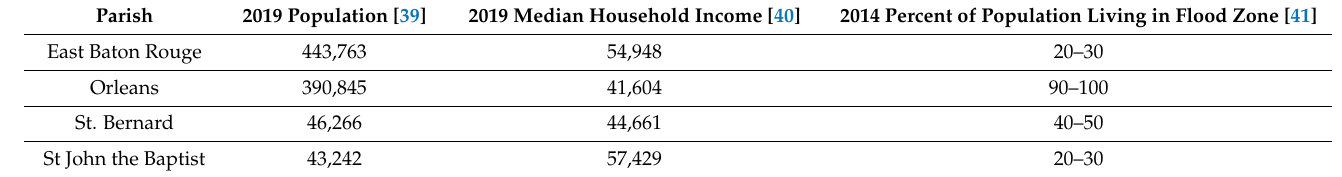
Table 1. Demographic characteristics of study